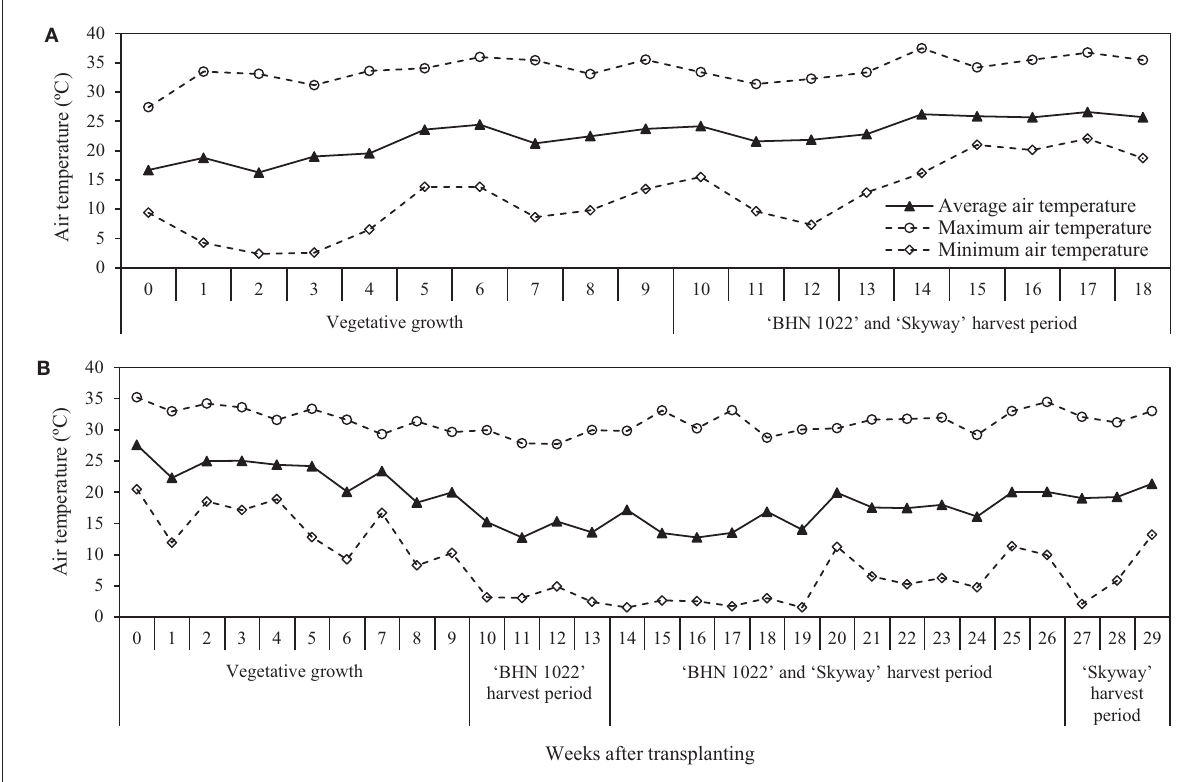
FIGURE1 Weekly average, maximum, and minimum air temperatures at 1m above the planting bed in the center of the high tunnel in (A) spring planting (data collected from 15 February to 18 June 2020) and (B) fall planting (data collected from 25 September 2020 to 15 April 2021). For the spring planting, week 0 included 15 February, week 1 included the period of 16–22 February, and so forth. For the fall planting, week 0 included the period of 25–26 September, week 1 included the period of 27 September–3 October, and so forth.